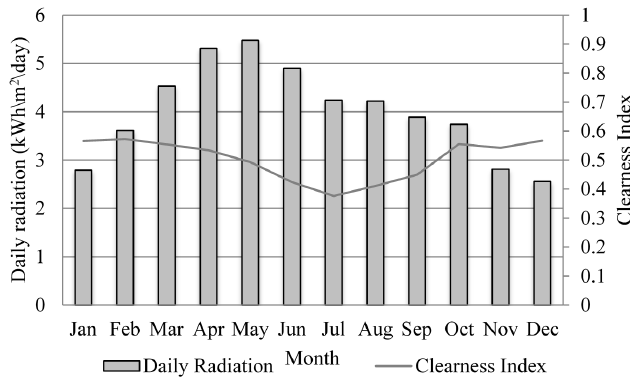
Figure 6. Monthly average solar global horizontal irradiance at 35.5° latitude and 127.5° longitude [26,27].